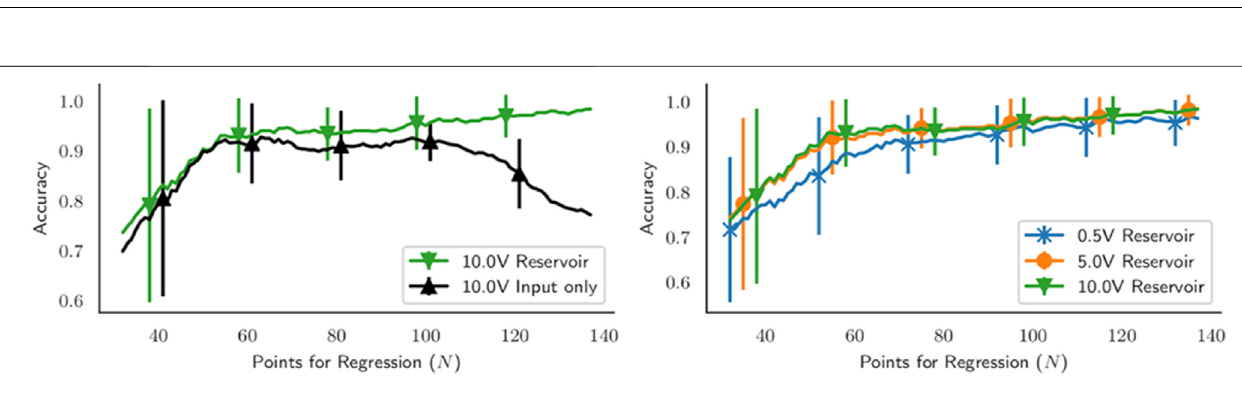
Frontiers in Nanotechnology |